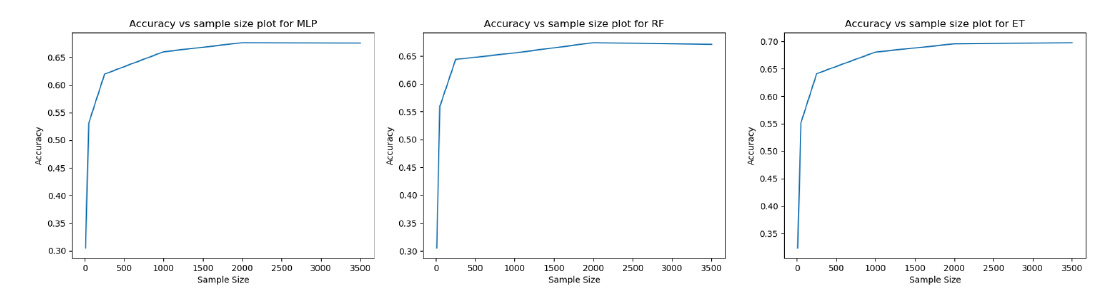
Figure 9. Accuracy vs sample size plot for the three models (MLP, RF and